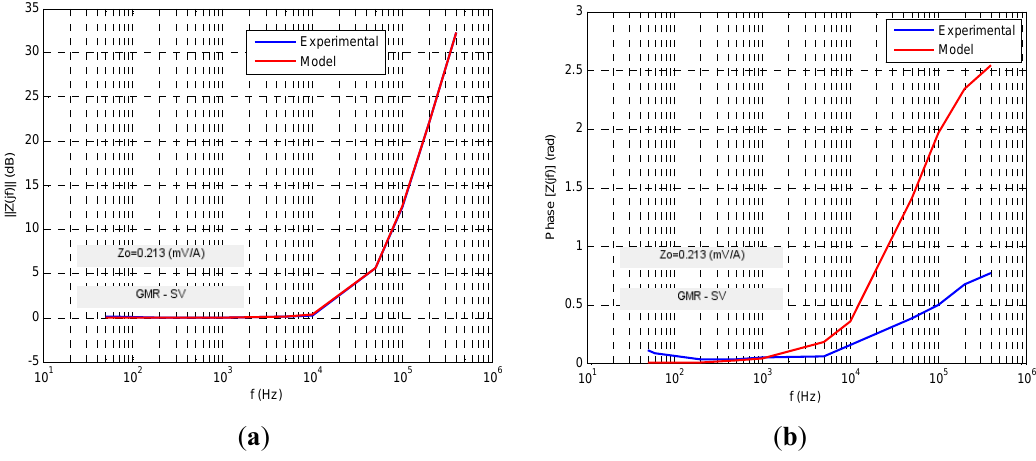
Figure 12. GMR-SV sensor ac large-signal fractional modeling.